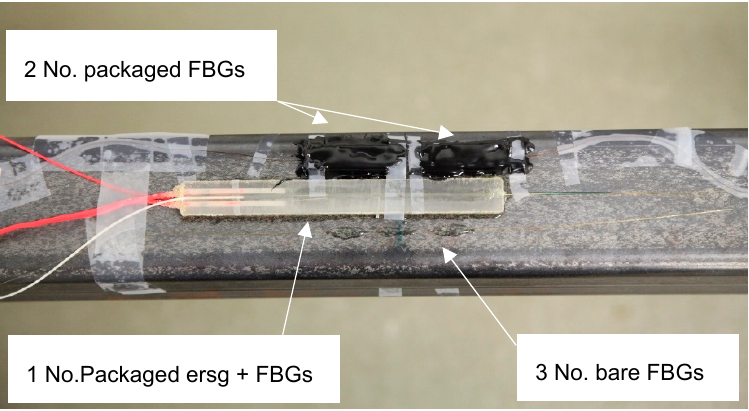
Figure 10. Detail of sensor layout on steel beam.